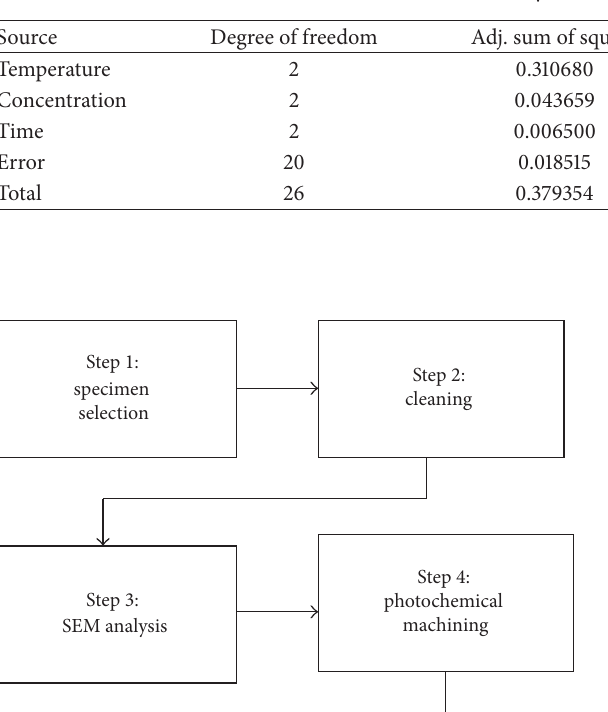
Table 3: Summary of ANOVA for surface roughness.